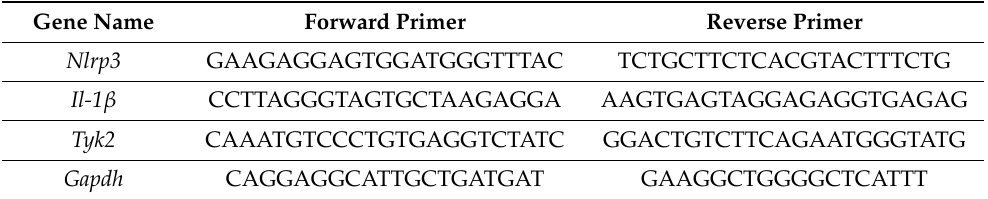
Table 2. List of primers used for